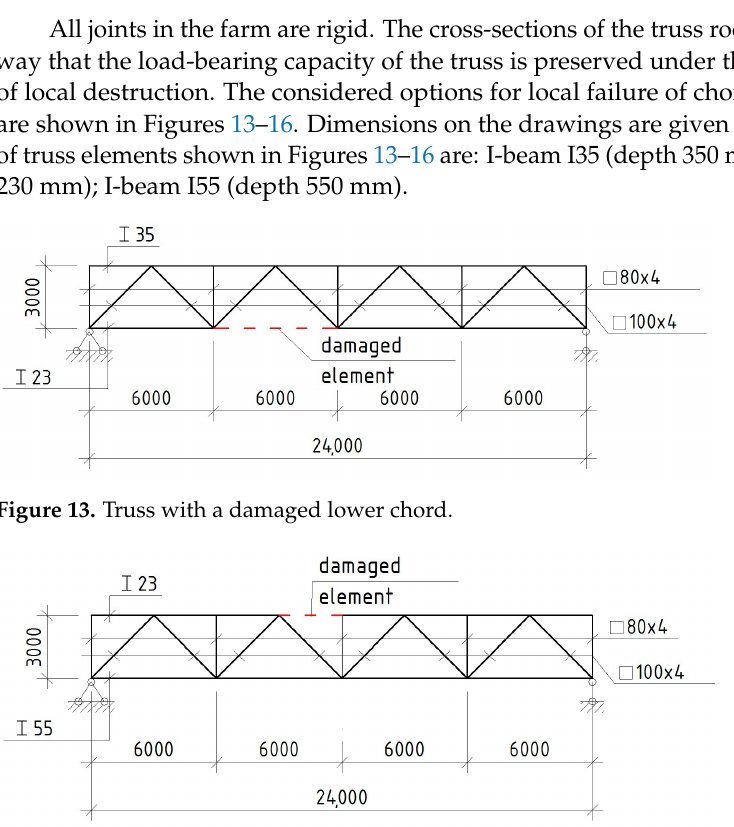
Figure 12. Truss with a span of 24 m.